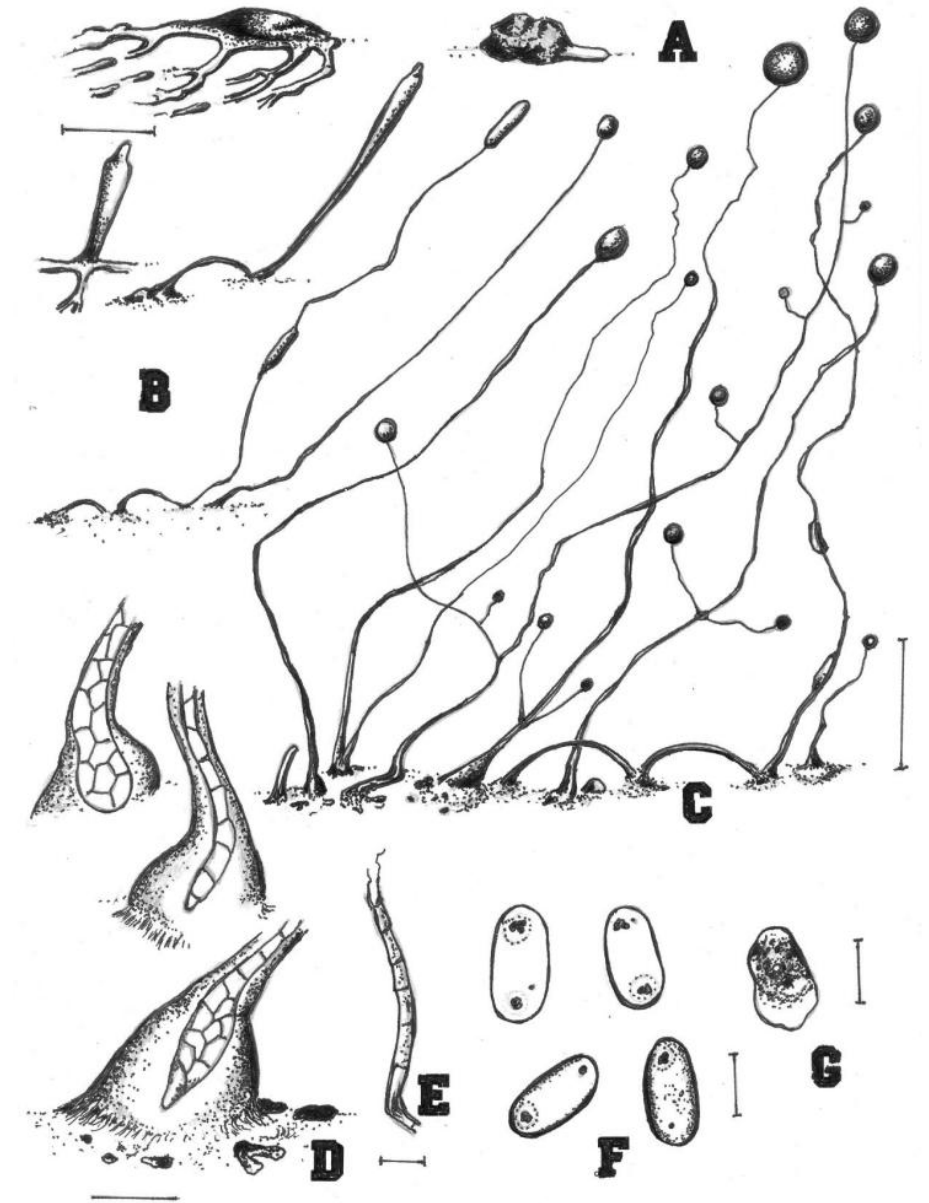
Figure 4. Morphological features of Cavenderia parvibrachiata (TH20C). ( A ), Small shortly radiated aggregation with partite streams (left); very short blocky-streamed mound-like aggregation (right). ( B ), Early central sorogen with short streams at base (above left), a stoloniferous early late elongated sorogen (above, right); stoloniferous habit of migrating late sorogen with an ascending pseudoplas- modial mass, stalk broken from early stages (below, left); solitary unbranched early mature slender small sorocarp (below, right). ( C ), Crowded group of sorocarps; tight clustered unbranched sorocarps within numerous smaller curved-broken fruiting bodies and sorogens (left); lower branched sorocarps, branches are short, sometimes coincident at one point (center); a stoloniferous sorocarp with a more evident broken sorophore and its companion small fruiting body (right). ( D ), Round base (left, above) clavate one-celled sorophore base (center); acutely clavate regular base within a hyaline mass of slime, sheath is not profuse and there are small masses of slime at base (below). ( E ), Simple tip frequently with a small cell with two piliform ends, flexuous. ( F ), Short small elliptical spores with irregular consolidated PG, one with halo. ( G ), Myxamoeba. Bars: ( A , B ) = 200 µ m; ( C ) = 0.5 mm; ( D ) = 20 µ m; ( E ) = 10 µ m; ( F ) = 5 µ m; ( G ) = 10 µ